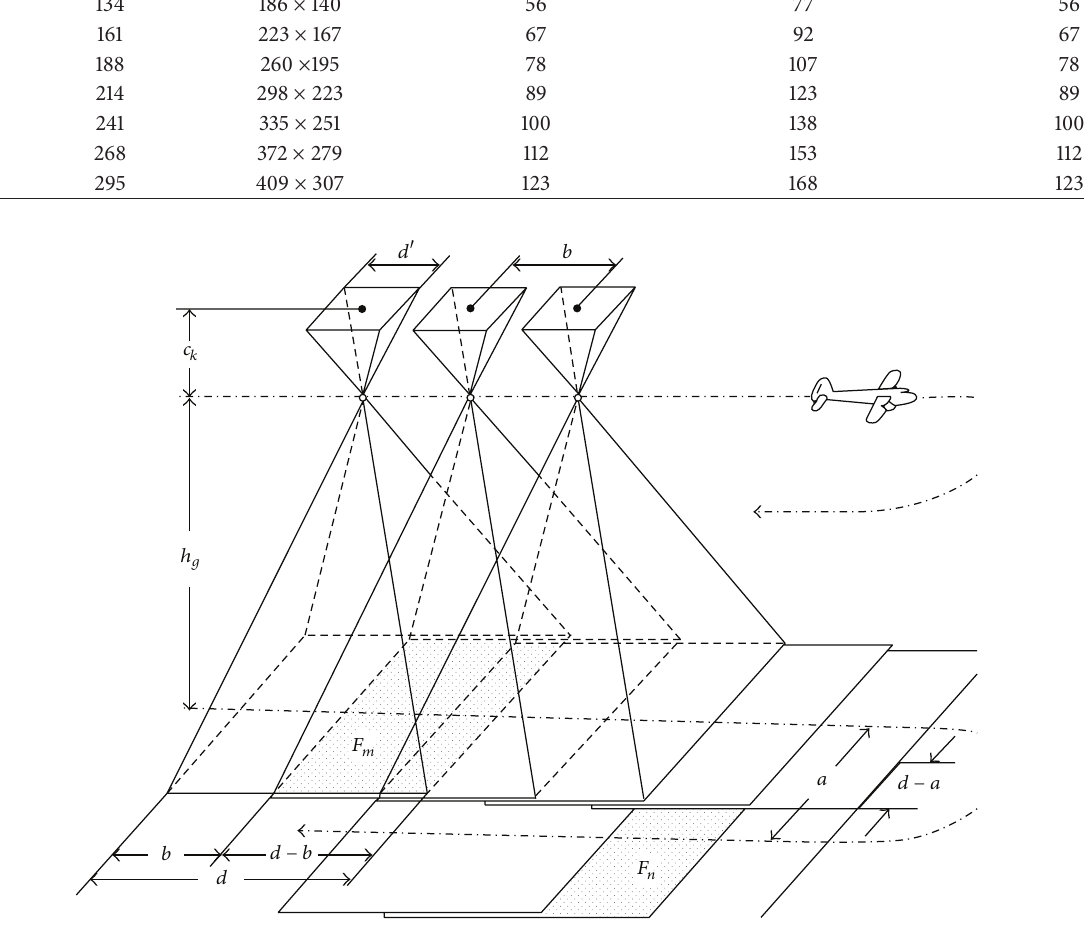
Figure 2: Flight project